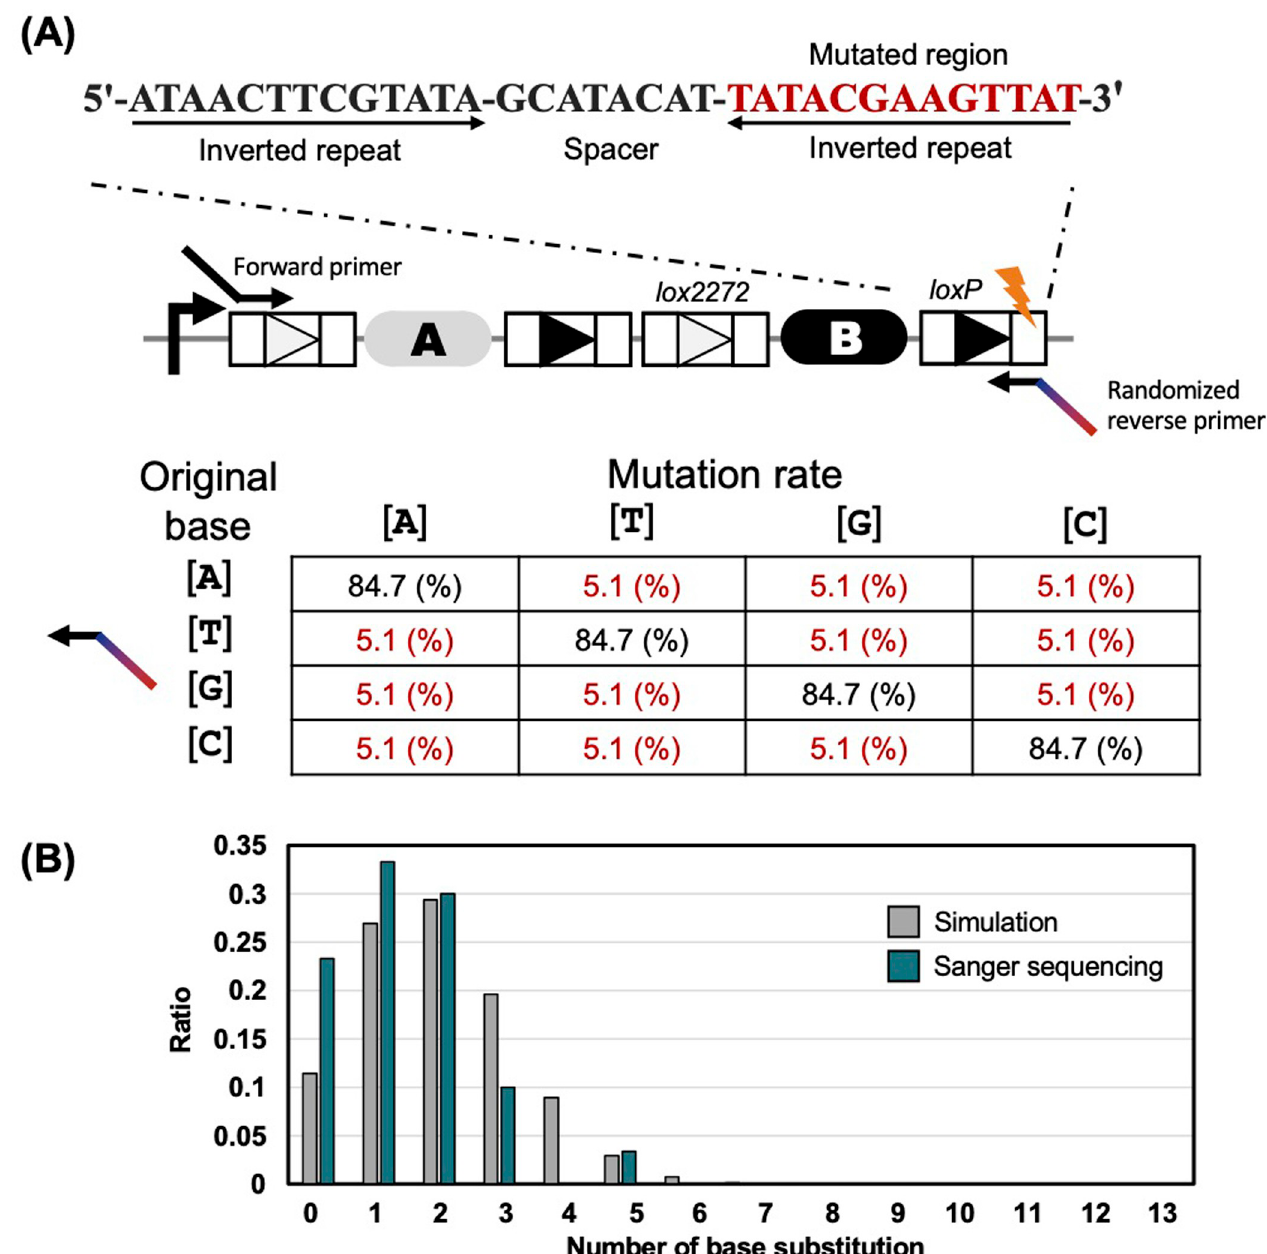
Fig 3. Primer design to construct a library of loxP variants. (A) Primer design to mutagenize the loxP sequence. We introduced a mutation into the right arm (13 bp) of the loxP sequence. The right arm of the loxP sequence is shown in red. We set the mutation rate of the primer to 15.3% to obtain as many 2-base substitutions as possible. When the mutated rate in randomized primer is 15.3%, 2-base substitutions are most efficiently obtained. (B) Validation of the distribution of the number of base substitutions by Sanger sequencing. Gray indicates the theoretical value (mutation rate = 15.3%). Green indicates the results of Sanger sequencing. The detailed results of Sanger sequencing are provided in S1 Table